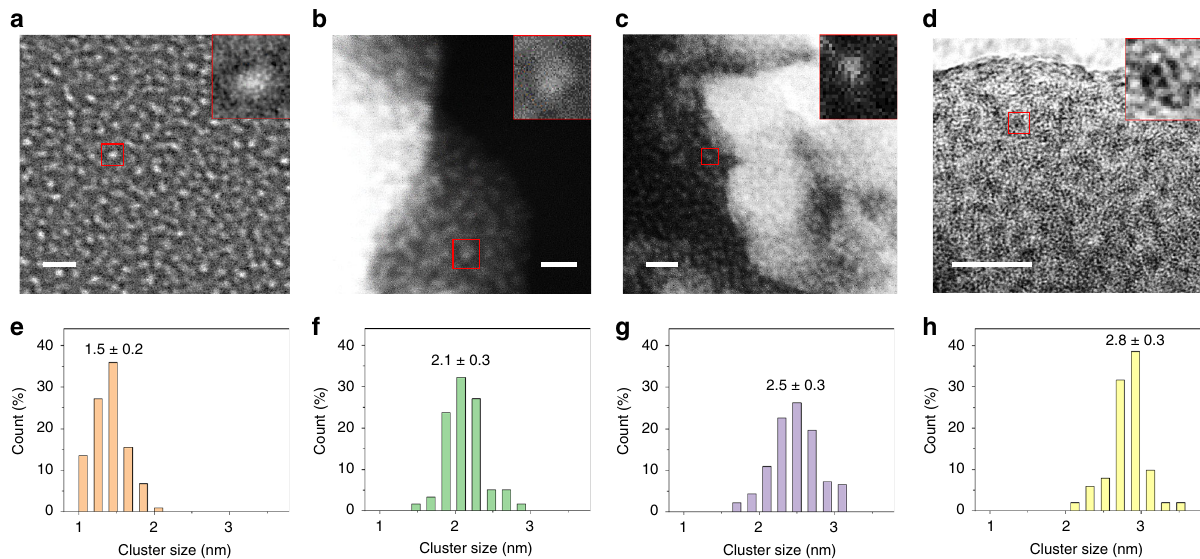
Fig. 2 Preparation and characterization of cobalt(II) oxide clusters. a – d Transmission electron micrograph images and e – h corresponding size distribution of CoO clusters. The white light dots in ( a – c ) and dark black dots in ( d ) are the CoO clusters. Insets in ( a – d ) are the enlarged images showing the individual CoO cluster in red square. The scale bars in ( a , b ) and ( c , d ) are 5 and 10 nm,